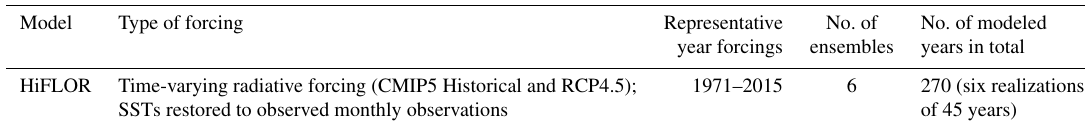
Table 2. Restored SST experiments performed with the HiFLOR